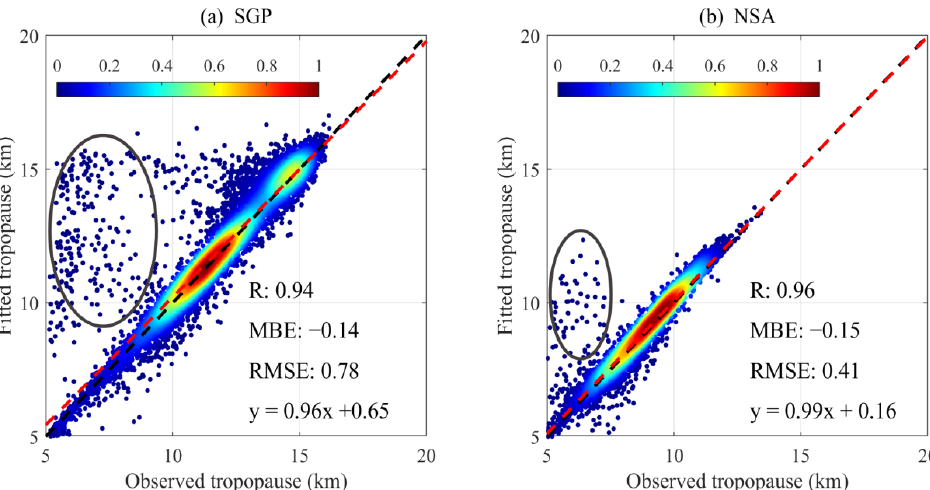
Figure 5. Data density plots of the observed and fitted tropopause heights at SGP ( a ) and NSA ( b ). The black dashed line in each panel denotes the 1:1 line, which highly overlaps with the linear regression line (dashed red line). The color bar shows the data density of the scatter points, with larger values representing a higher data density. The correlation coefficient (R), mean bias error (MBE; observed-fitted), root mean square error (RMSE), and linear regression equation between the two tropopause retrievals are also noted. The black ellipses delineate a few outliers that were induced by mismatches between the observed and fitted tropopause heights when multiple tropopause heights are identified on one radiosonde profile.